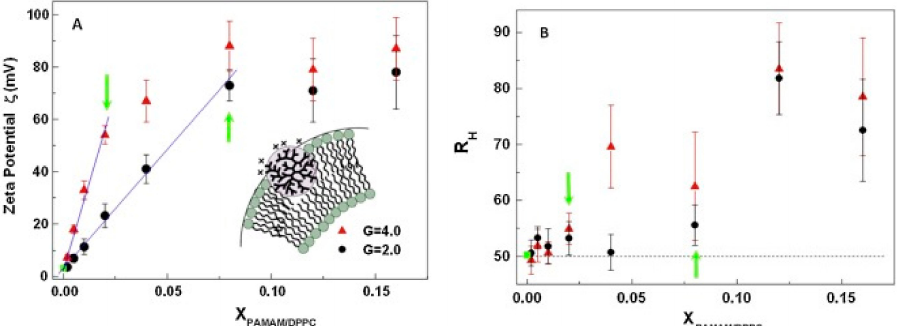
Figure 2. Measurements of: ( A ) Zeta potentials of extruded liposomes as a function of dendrimer-liposomes concentration, for G2-Poly(amidoamine) (PAMAM) and G4-PAMAM dendrimers. ( B ) Hydrodynamic radius of PAMAM-liposomes mixed system. This Figure was provided thanks to Reference [81].